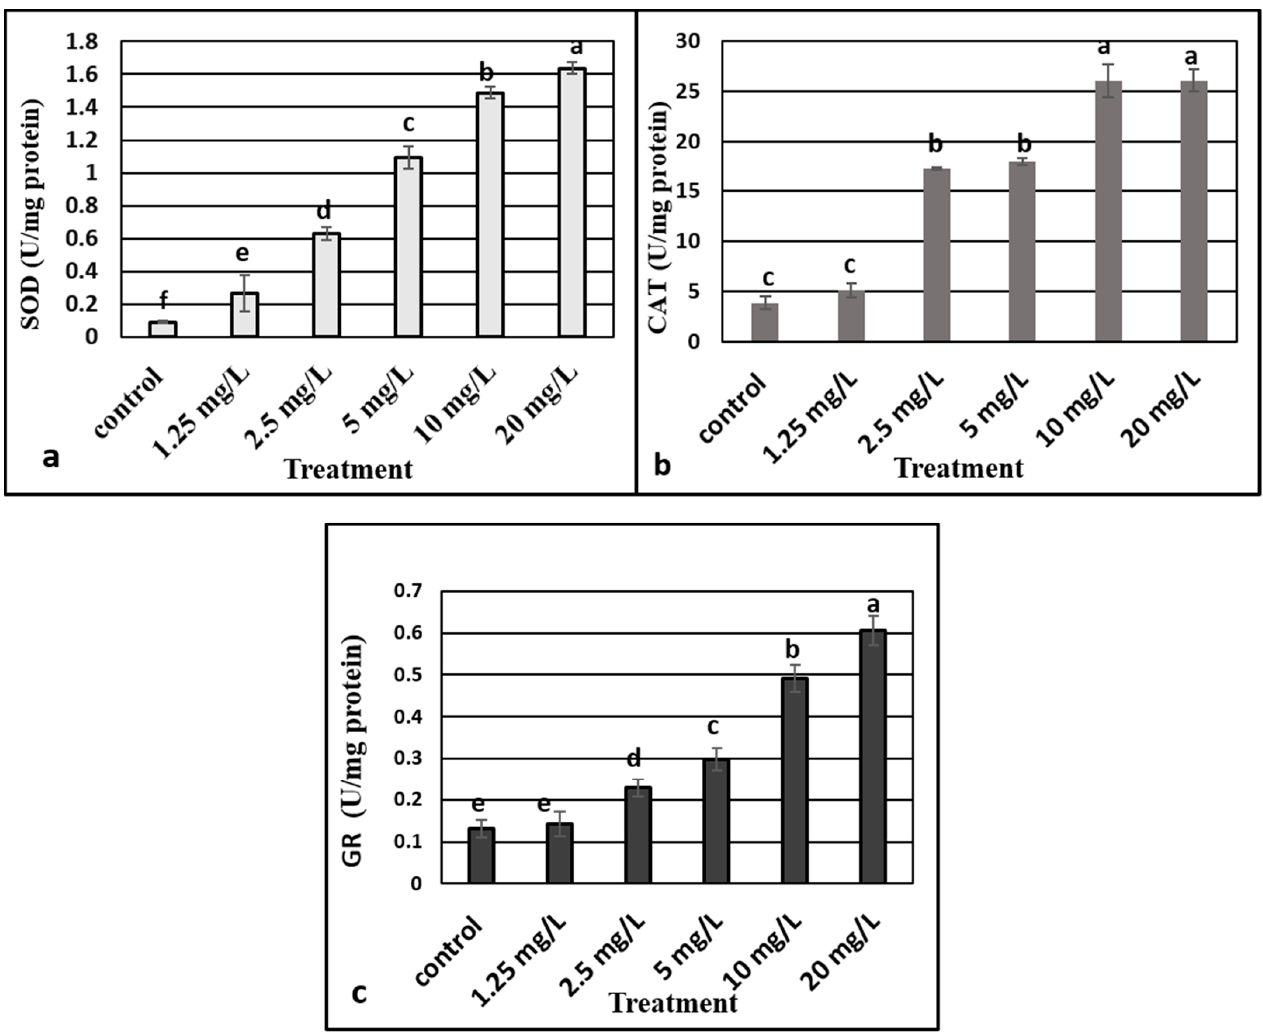
Figure 5. Effect of different concentrations of zinc oxide nanoparticles on superoxide dismutase (SOD) ( a ), catalase ( b ), and GR ( c ) activities in Maerua oblongifolia. Means ± SD for each concentration followed by the same letters are not significantly different according to one-way analysis of variance ( p ≤ 0.05).